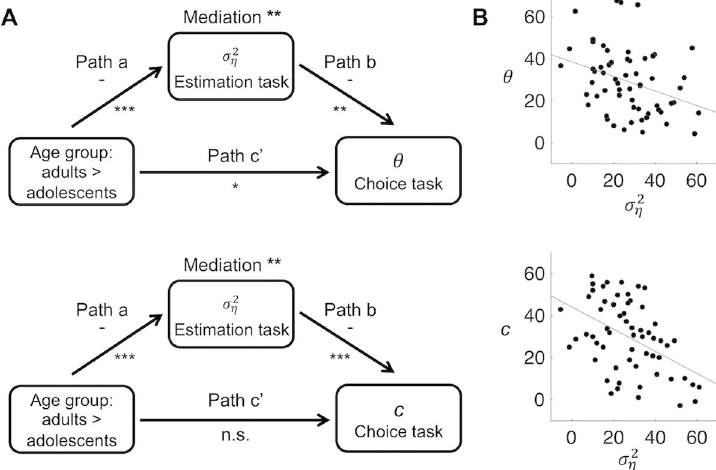
Fig 6. Relationships between age group and model parameters σ 2 θ and c , we used the medians of the posterior distributions of the individual-level parameters, and converted these into ranks. ��� p < .001, �� p < .01, � p < .05, n.s. not significant. B . Across-subject relationships between s 2 and c (all converted to ranks), controlled for age group (path b of the mediation models). The partial between s 2 Z correlations are r = -.33, p = .01 r = -.47, p < .001,